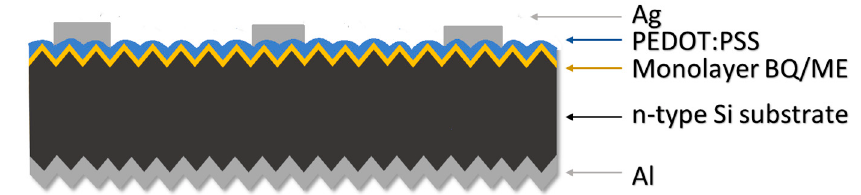
Figure 1. The schematic of the hybrid photovoltaic device architecture.